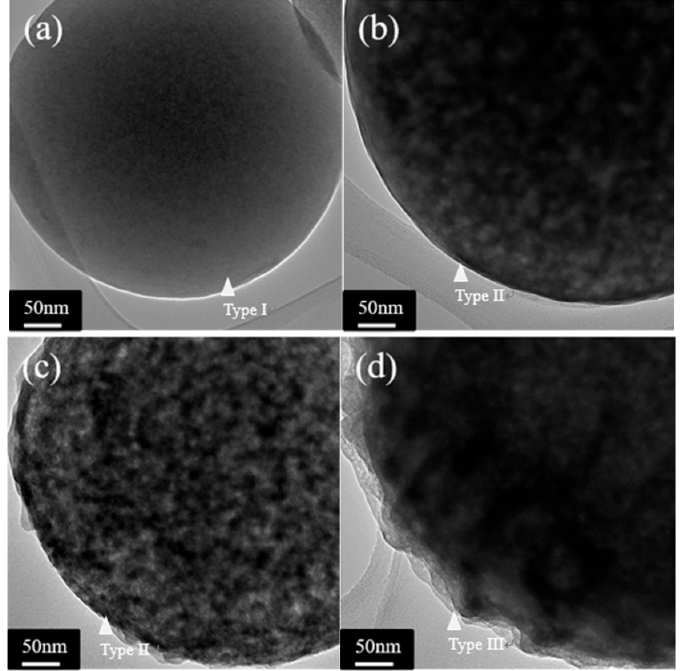
Figure 3. TEM micrographs of ( a ) untreated BG powders, and ( b ) 1M, ( c ) 2M, ( d ) 3M HAc-treated BG powders.